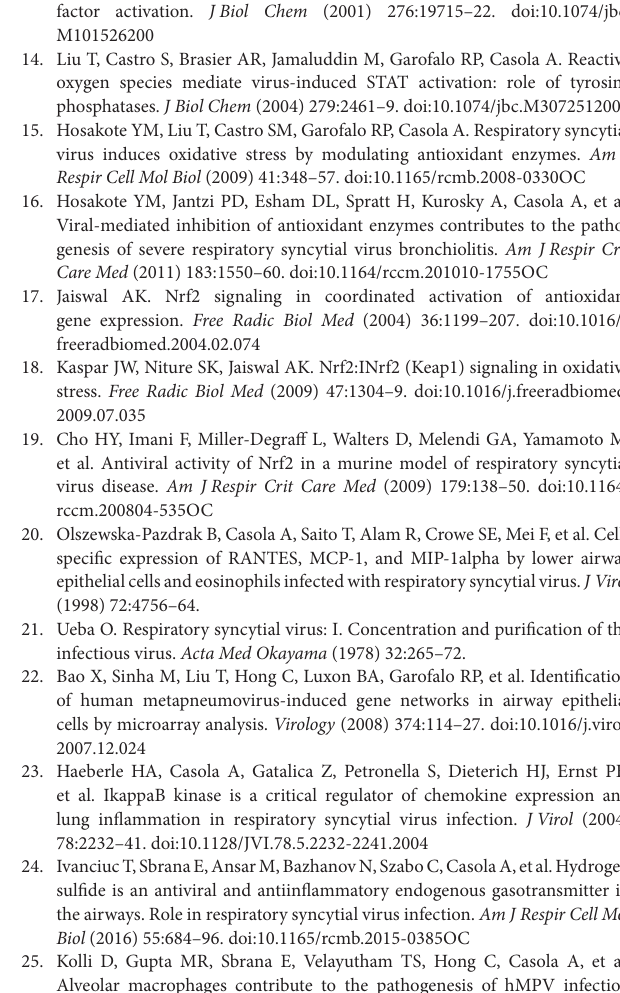
FigUre s1 | GYY4137 treatment reduces respiratory syncytial virus (RSV) replication in NF-E2-related factor 2 (Nrf2) KO mice. Nrf2 KO and wild type (WT) mice were treated intranasally with GYY4137 (50 mg/kg body weight) or an appropriate volume of vehicle (PBS) 1 h before, 6 and 20 h after infection. Mice were inoculated with either RSV (1 × 10 7 plaque-forming units/mouse) or PBS. At day 5 after infection, lungs were excised and viral replication was determined by plaque assay. Data are expressed as mean ± SEM ( n = 3 mice/group). * p < 0.05 Nrf2 KO/PBS/RSV compared with WT/PBS/RSV, Nrf2 KO/GYY4137/ RSV compared with WT/GYY4137/RSV, *** p < 0.001 WT/PBS/RSV compared with WT/GYY4137/RSV, and Nrf2 KO/PBS/RSV compared with Nrf2 KO/